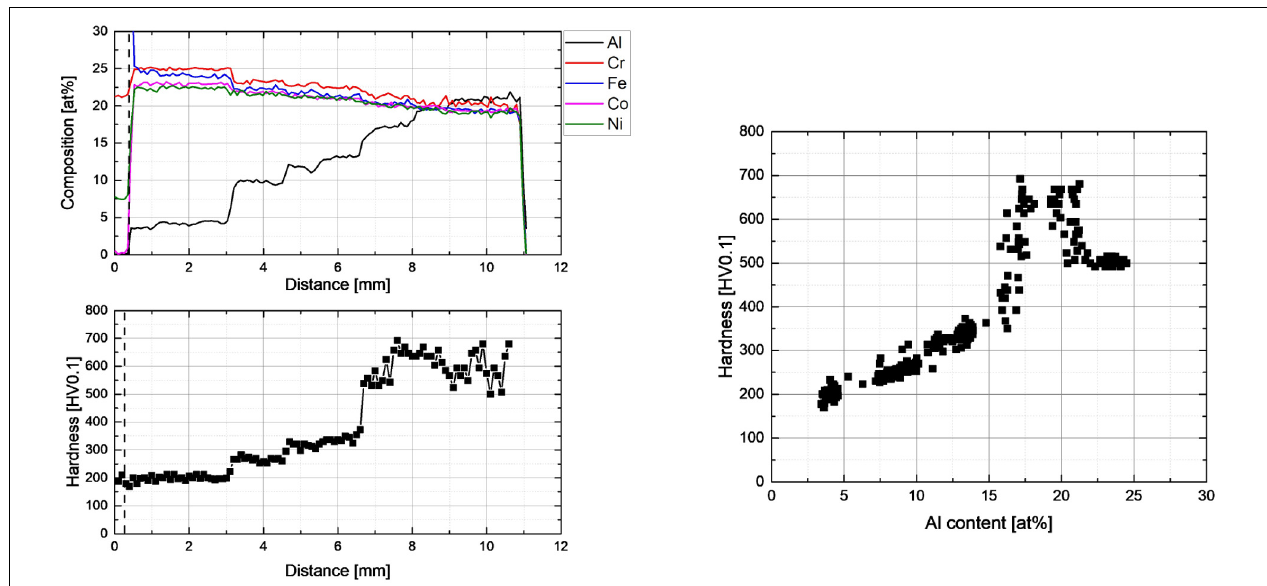
FIGURE 8 | Chemical composition and hardness of the 5/15/25 at% Al gradient structure after heat treatment (left); hardness as a function of Al content derived from all three heat treated gradients